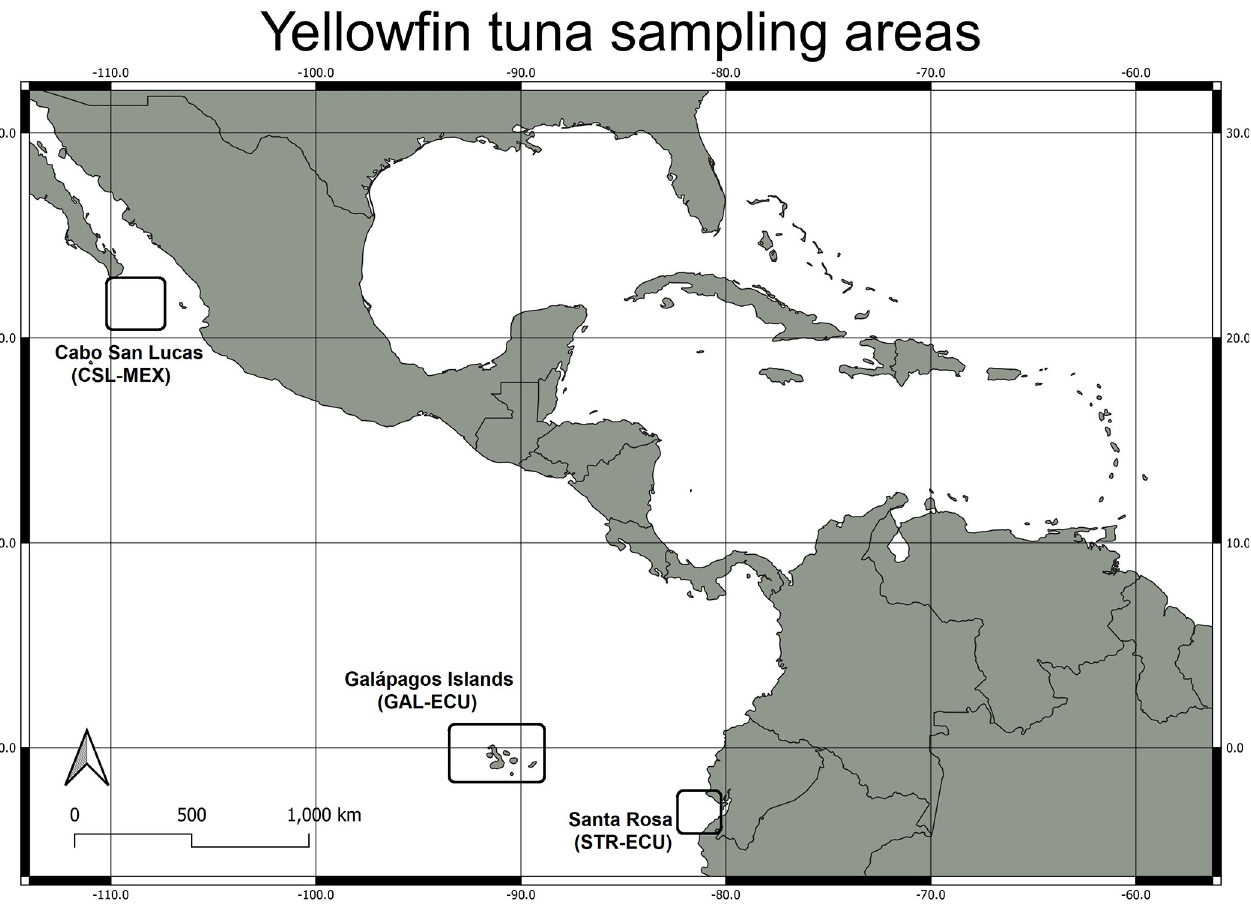
Fig 1. Approximate sampling areas of yellowfin tuna in the Eastern Pacific Ocean. This figure was produced in QGIS.